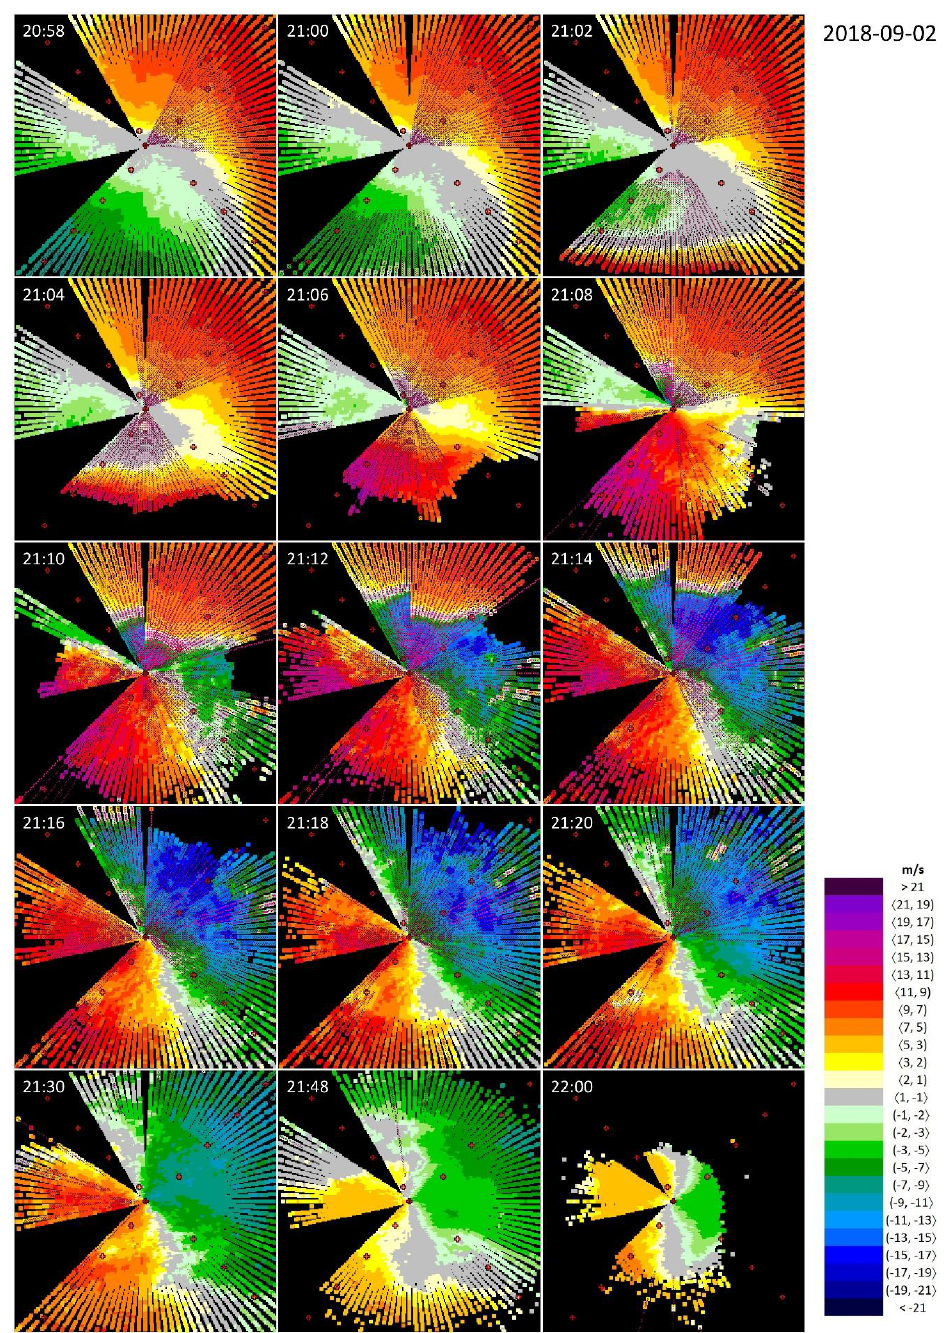
Figure 10. Wind shear at the passage of a gust front from 20:58 UTC to 22:00 UTC on 2 September 2018, seen by the lidar at the Bratislava Airport located at the center of each figure. Wind blowing towards the lidar is defined as positive. The empty (full) pink circles indicate wind shear condition (microburst condition) according to the ICAO thresholds.